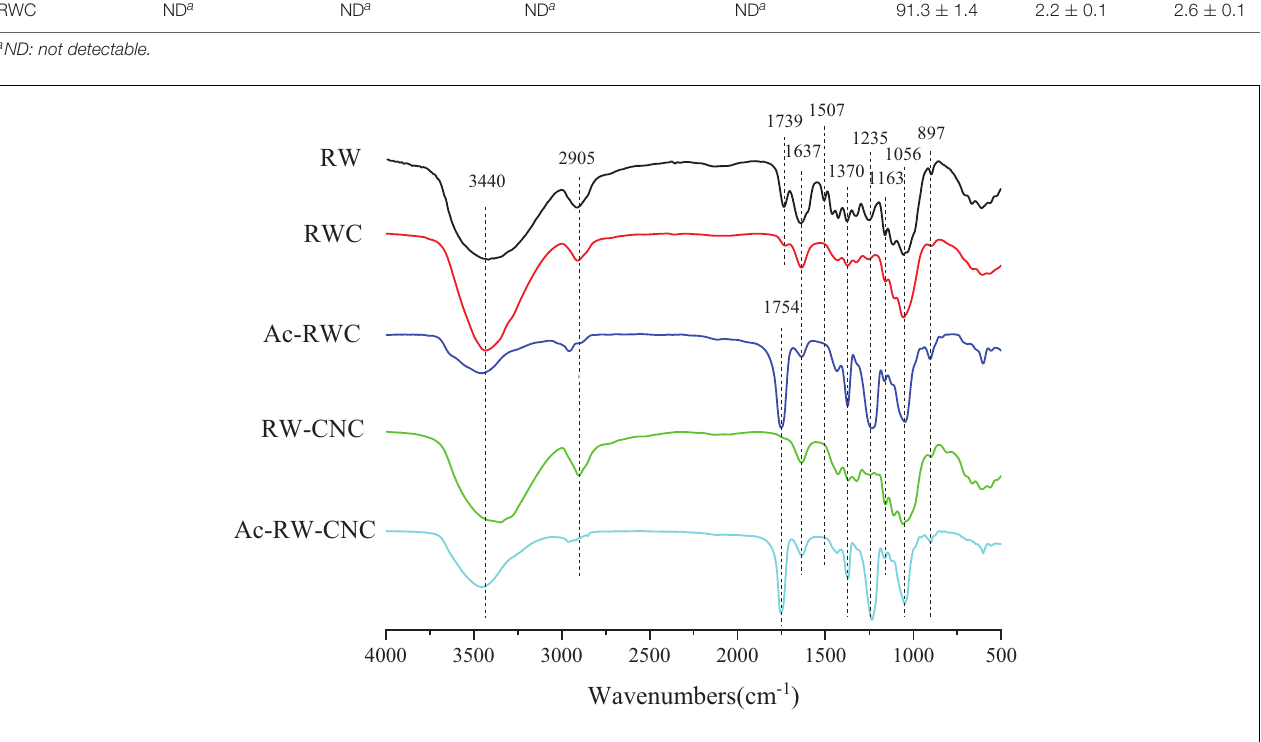
FIGURE 2 | FTIR spectra of RW, RWC, Ac–RWC, RW–CNC, and